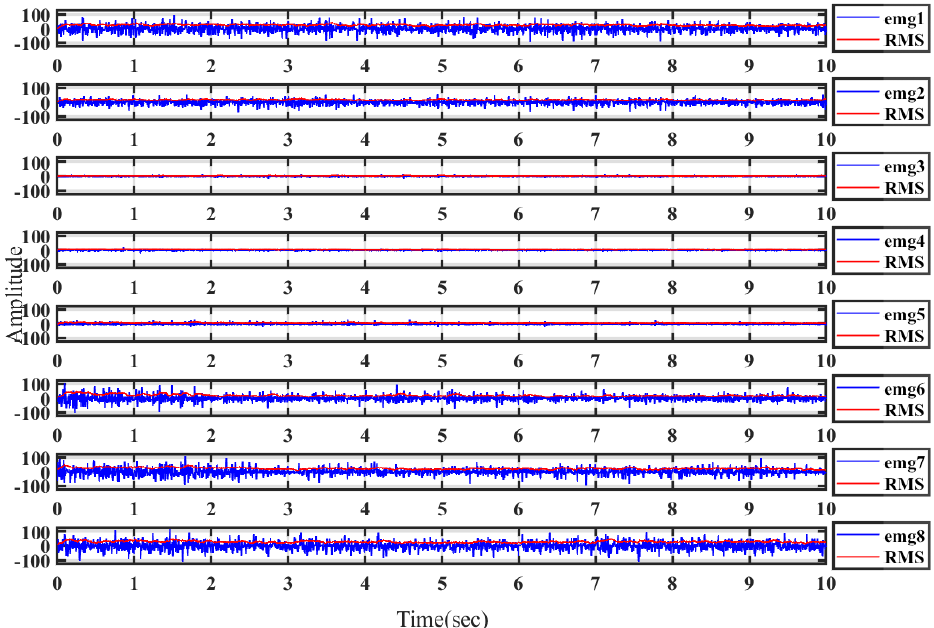
Figure 24. Gesture 3 (wave-in) maintained for 10 s. The EMG signal and RMS graph of the eight sensors in the sEMG bracelet.